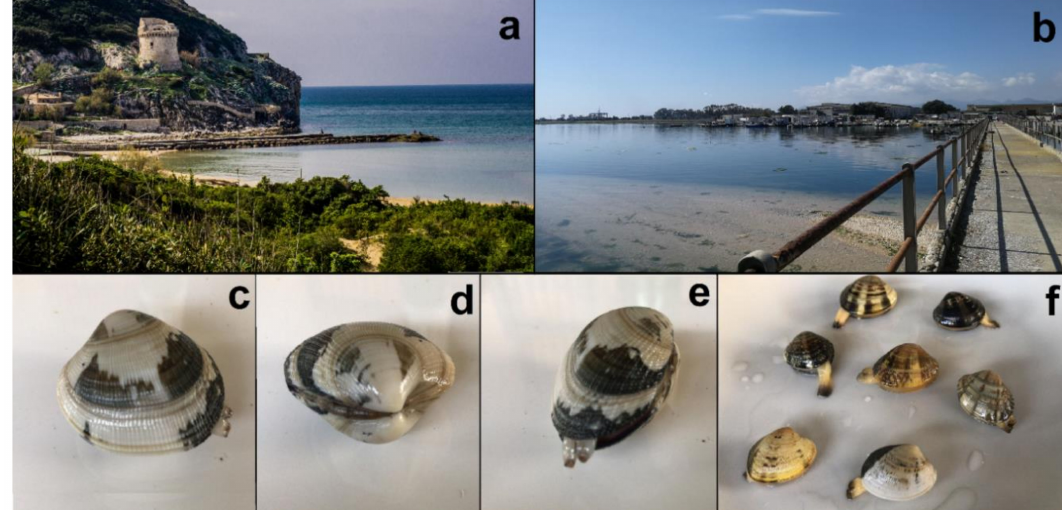
Figure 5. Lago di Paola, Latium, Italy: detail of the mouth channel, photo credit: D. Ventura ( a ) and Santa Gilla lagoon, Sardinia, Italy, photo by courtesy of Serenella Cabiddu, University of Cagliari, Italy ( b ) as examples of sites where populations of the autochthonous Ruditapes decussatus occur; specimens of the allochthonous Ruditapes philippinarum, showing shells and the almost-fused siphons as diagnostic characters ( c – f ). Photo credit: A.